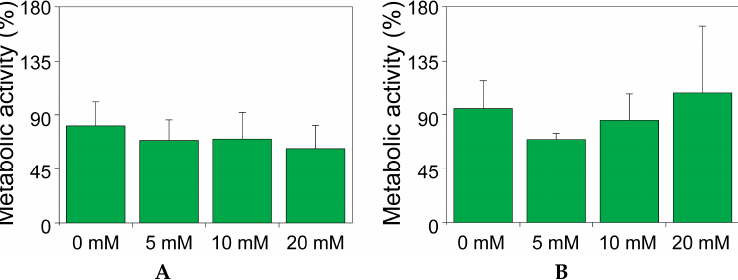
Figure 2. The effect of theophylline on the metabolic activity of MIN6 and INS1E cells. Metabolic activity of MIN6 ( A ) or INS1E ( B ) pseudo-islets cultured for 5 h in presence of different concentrations of theophylline. Data are presented as percentage of the metabolic activity at t = 0.